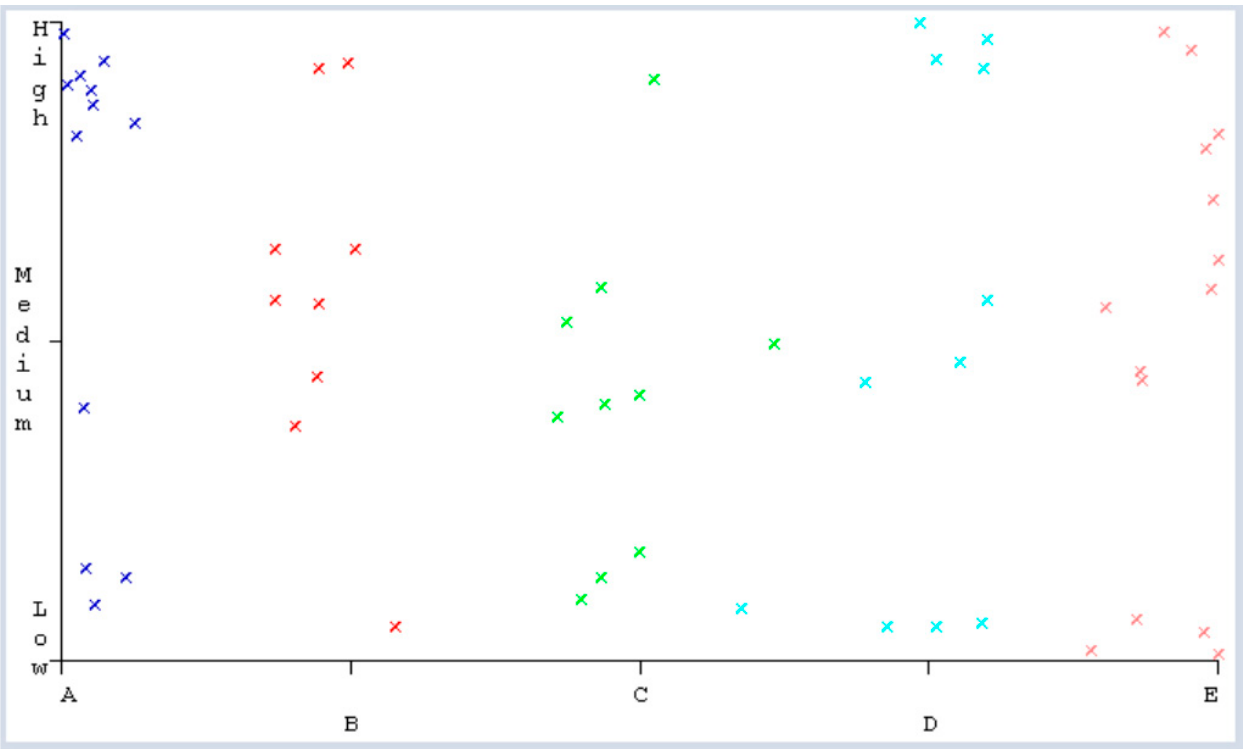
Figure 3. Visualization of analysis results between learning in relation to financial problems.